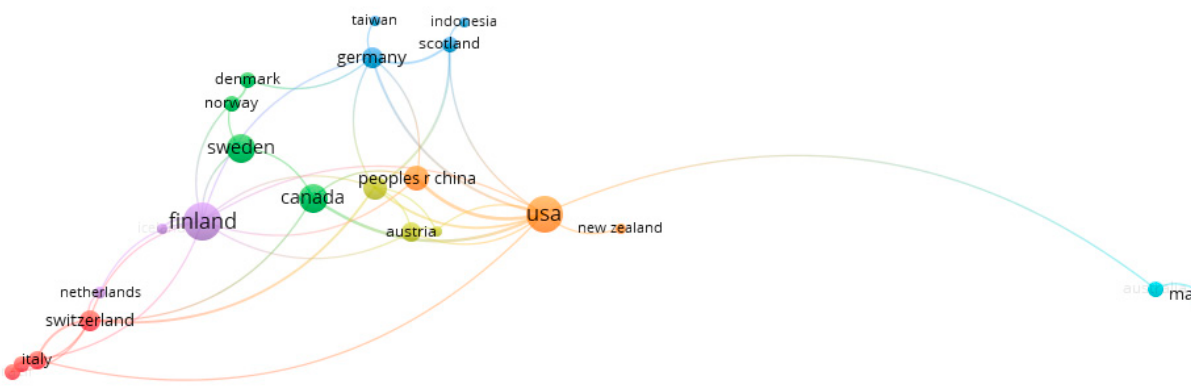
Figure 4. Country Figure 4. Country networks. Figure 4. Country networks.